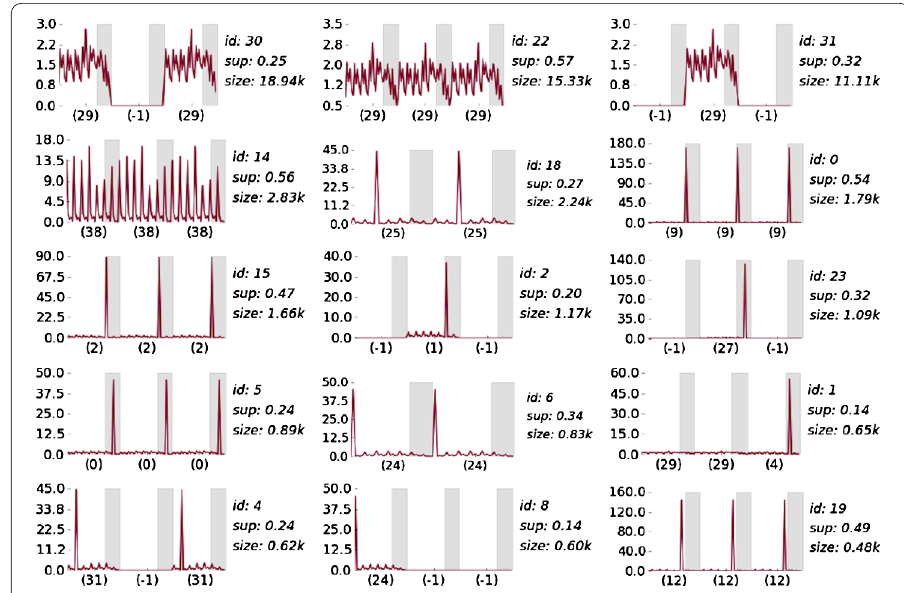
Figure 8 Regular sub-sequences. Selection of representative regular sub-sequences of the medoids of the collective clustering on the regular sub-sequences. Gray rectangles highlights the weekends, ( – 1) indicates the footprint modeling the no-shopping